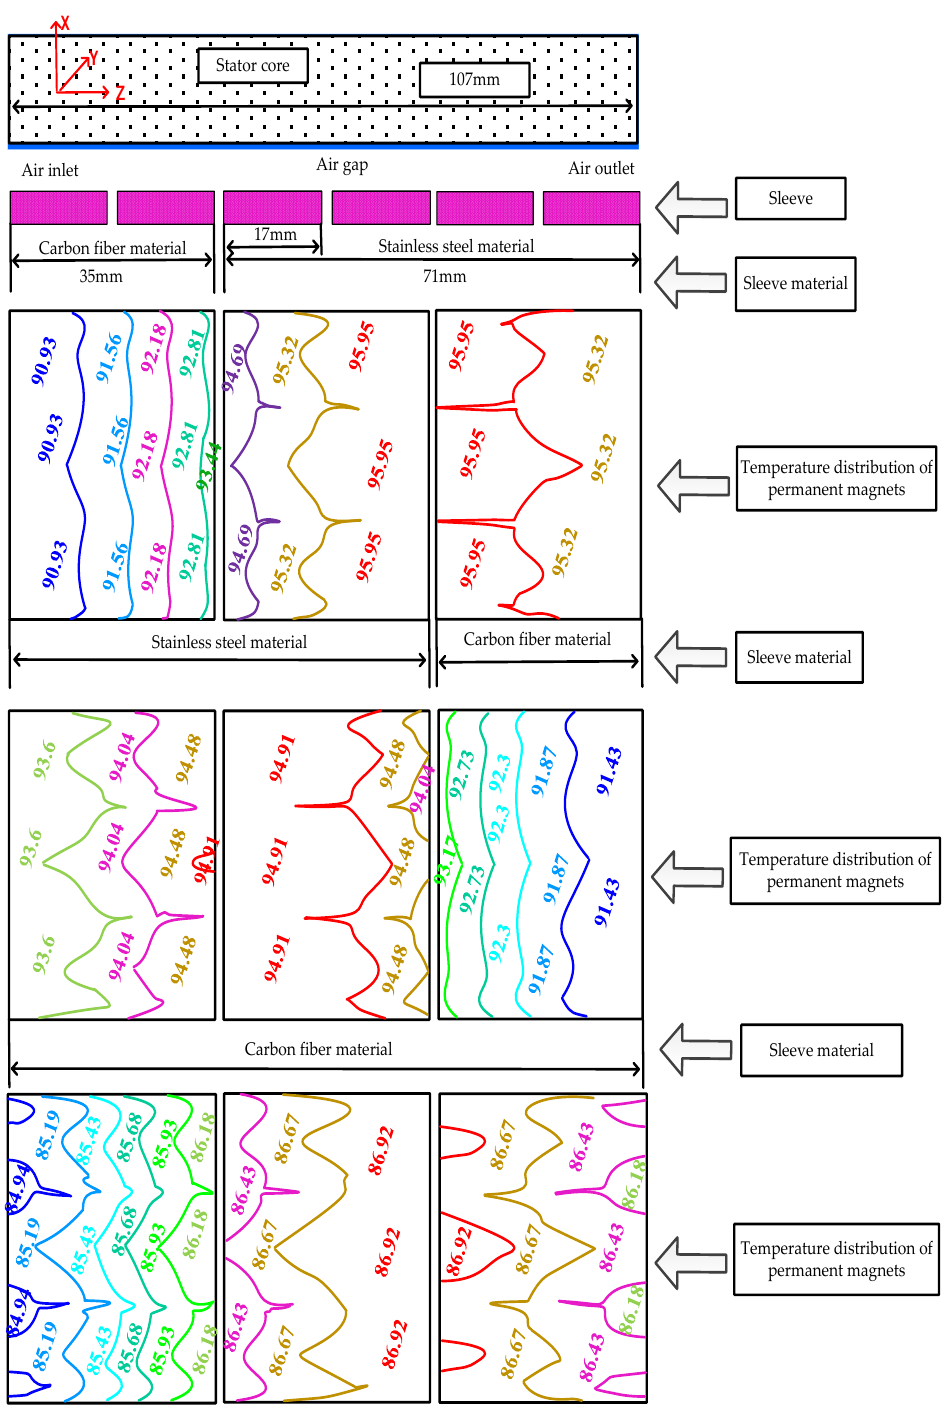
Figure 10. Temperature distribution of permanent magnets under three designs.